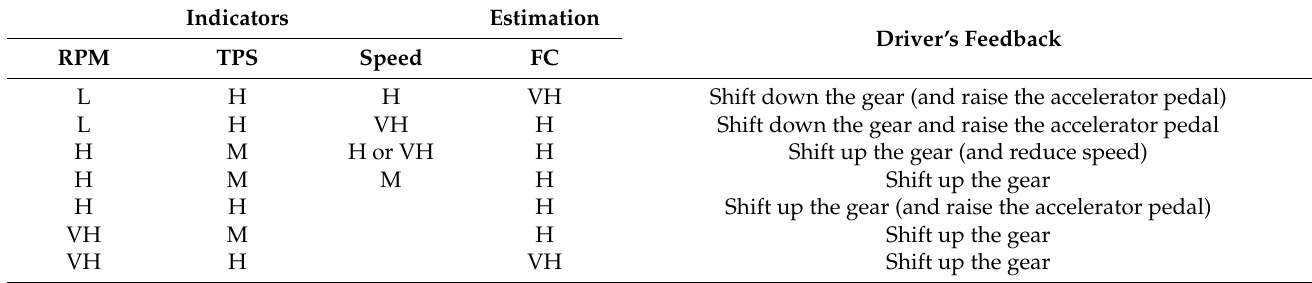
Table 3. Fuzzy logic rules and corresponding feedback for high and very high FC levels (L: Low, M: Medium; H: High, VH: Very